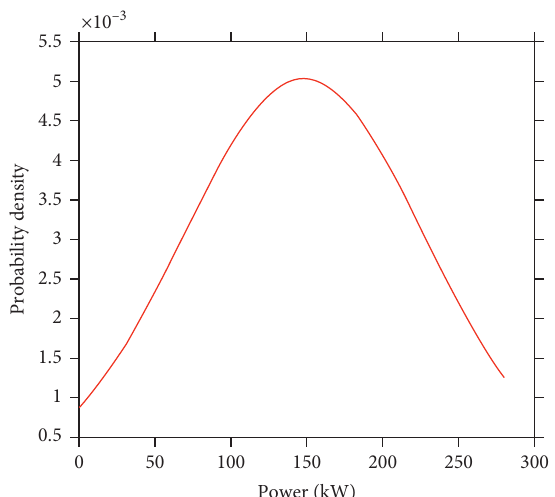
Figure 3: Probability density function of photovoltaic power generation.